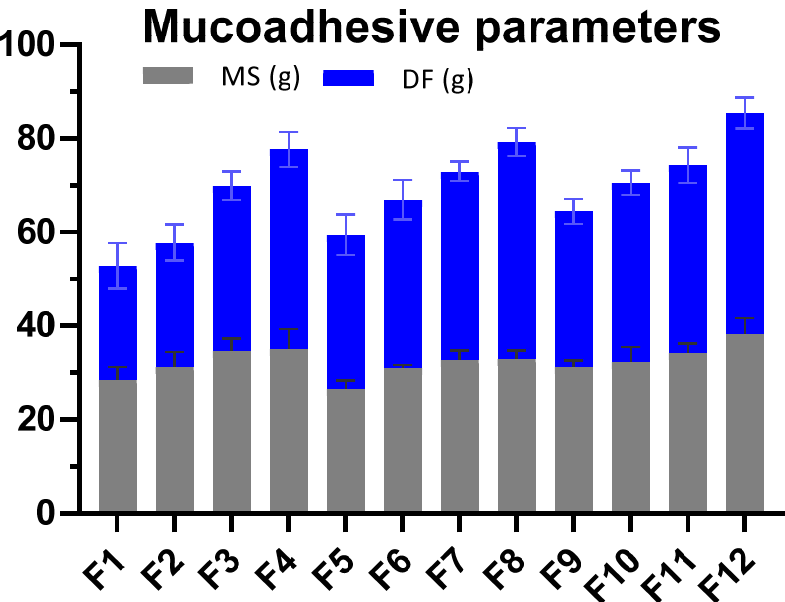
Figure 9. Comparison of the mucoadhesive strength properties of different gel fabricated